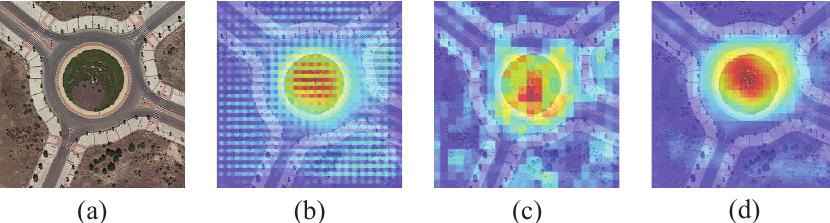
Figure 9. The heatmaps of different component for up-sampling. ( a ) Input image. ( b ) The heatmap after up-sampling with deconvolution. ( c ) is the heatmap after up-sampling with nearest neighbor interpolation. ( d ) is the heatmap after up-sampling with nearest neighbor interpolation and convolution (resize-convolution).